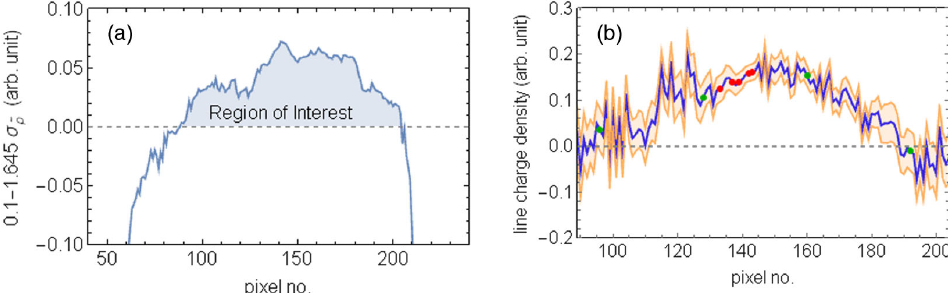
FIG. 3. Panel (a) displays a visualization of the selection criterion defining a pixel region of interest, considered for further data evaluation. (b) An example of an electron bunch density reconstruction for a single-shot measurement (blue line). The red and green dots indicate linearly interpolated data points from pixels with spikes originated from insufficient wire bonding and timing issues, respectively. The latter show up as spikes in the standard deviation of the modulated signal. The orange bands indicate the 68.3% confidence interval for the value of the reconstructed line charge